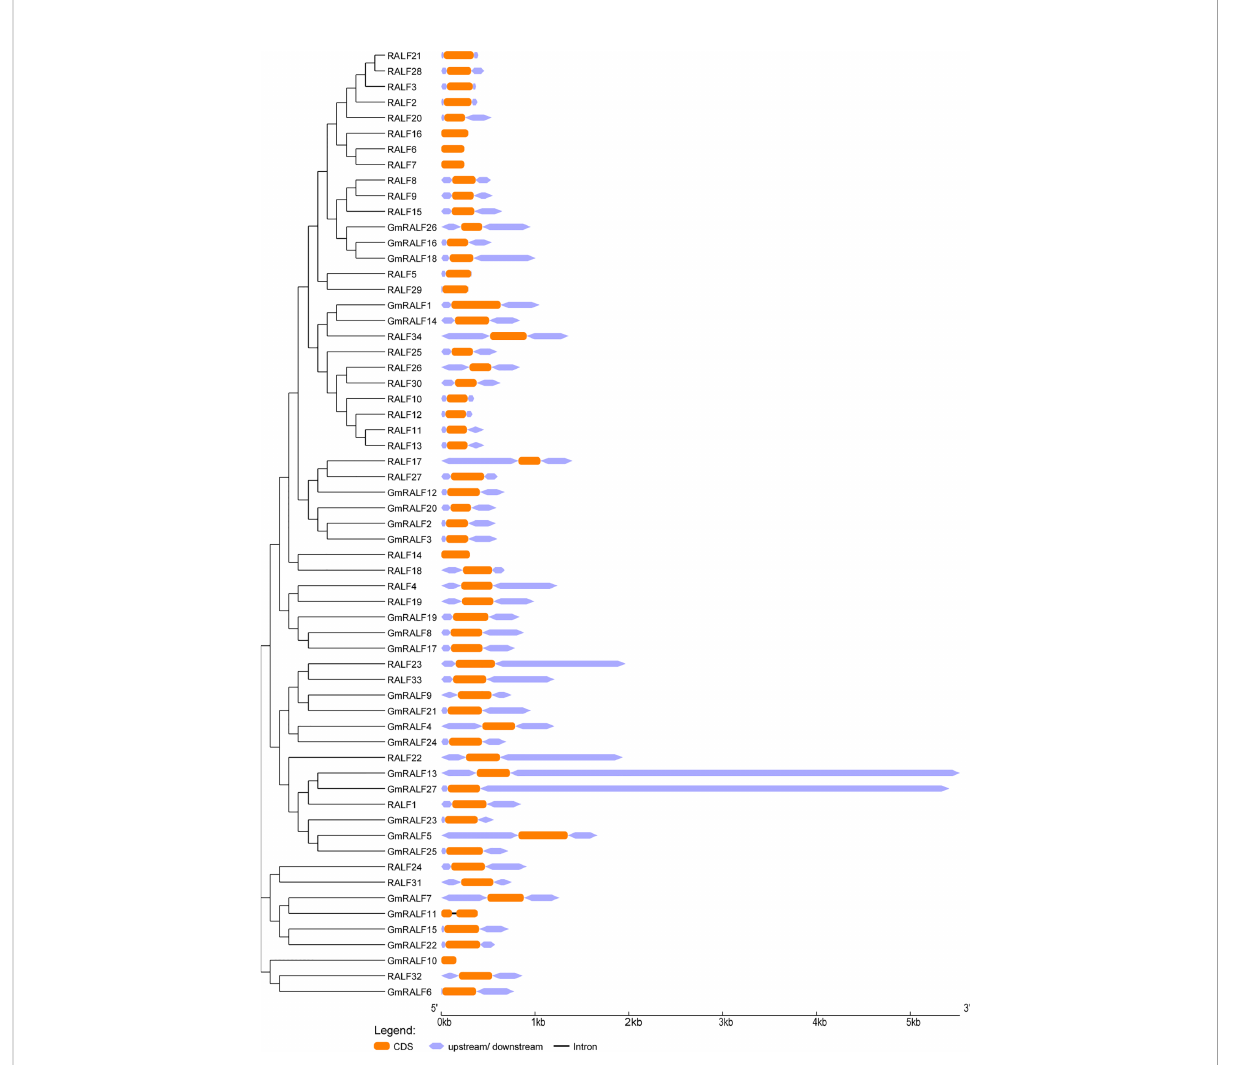
FIGURE 2 Phylogenetic clustering and gene structures of the RALF members in soybean and Arabidopsis . Left panel: phylogenetic clustering of the GmRALF members. The GmRALF members were classi fi ed into eight subfamilies. Right panel: gene structures of the GmRALF members. Orange boxes indicated the exons; Purplish boxes indicated un-translated 5 ′ - and 3 ′ -regions; black lines indicated